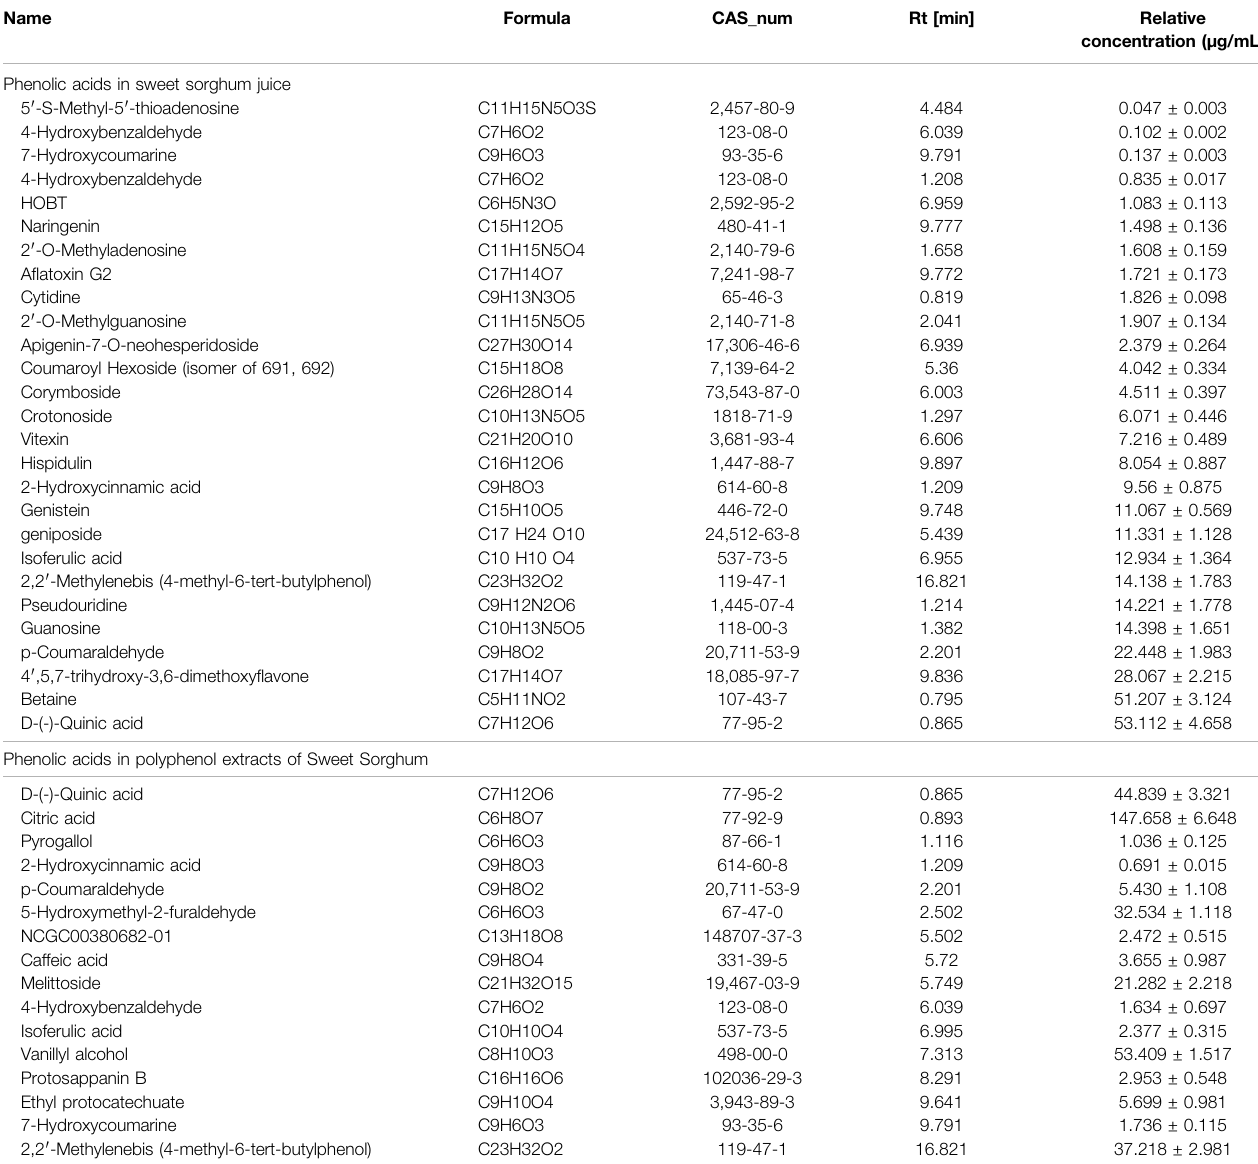
Phenol compound concentration μ g analyte/mL express. The data are mean ± standard deviation. Student t-test was used to determine the difference of statistical